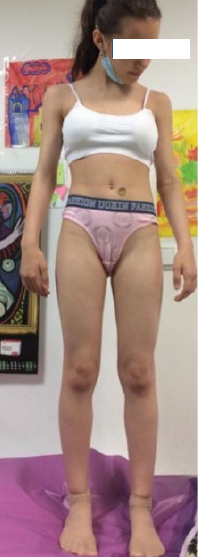
Figure 4. Case report 4: a five ‐ year ‐ old girl with low normal birth weight, height − 1.6 SD, BMI 29th percentile, tested positive for SHOX deletion due to her family history. She is too young to evaluate a mesomelic shortening.